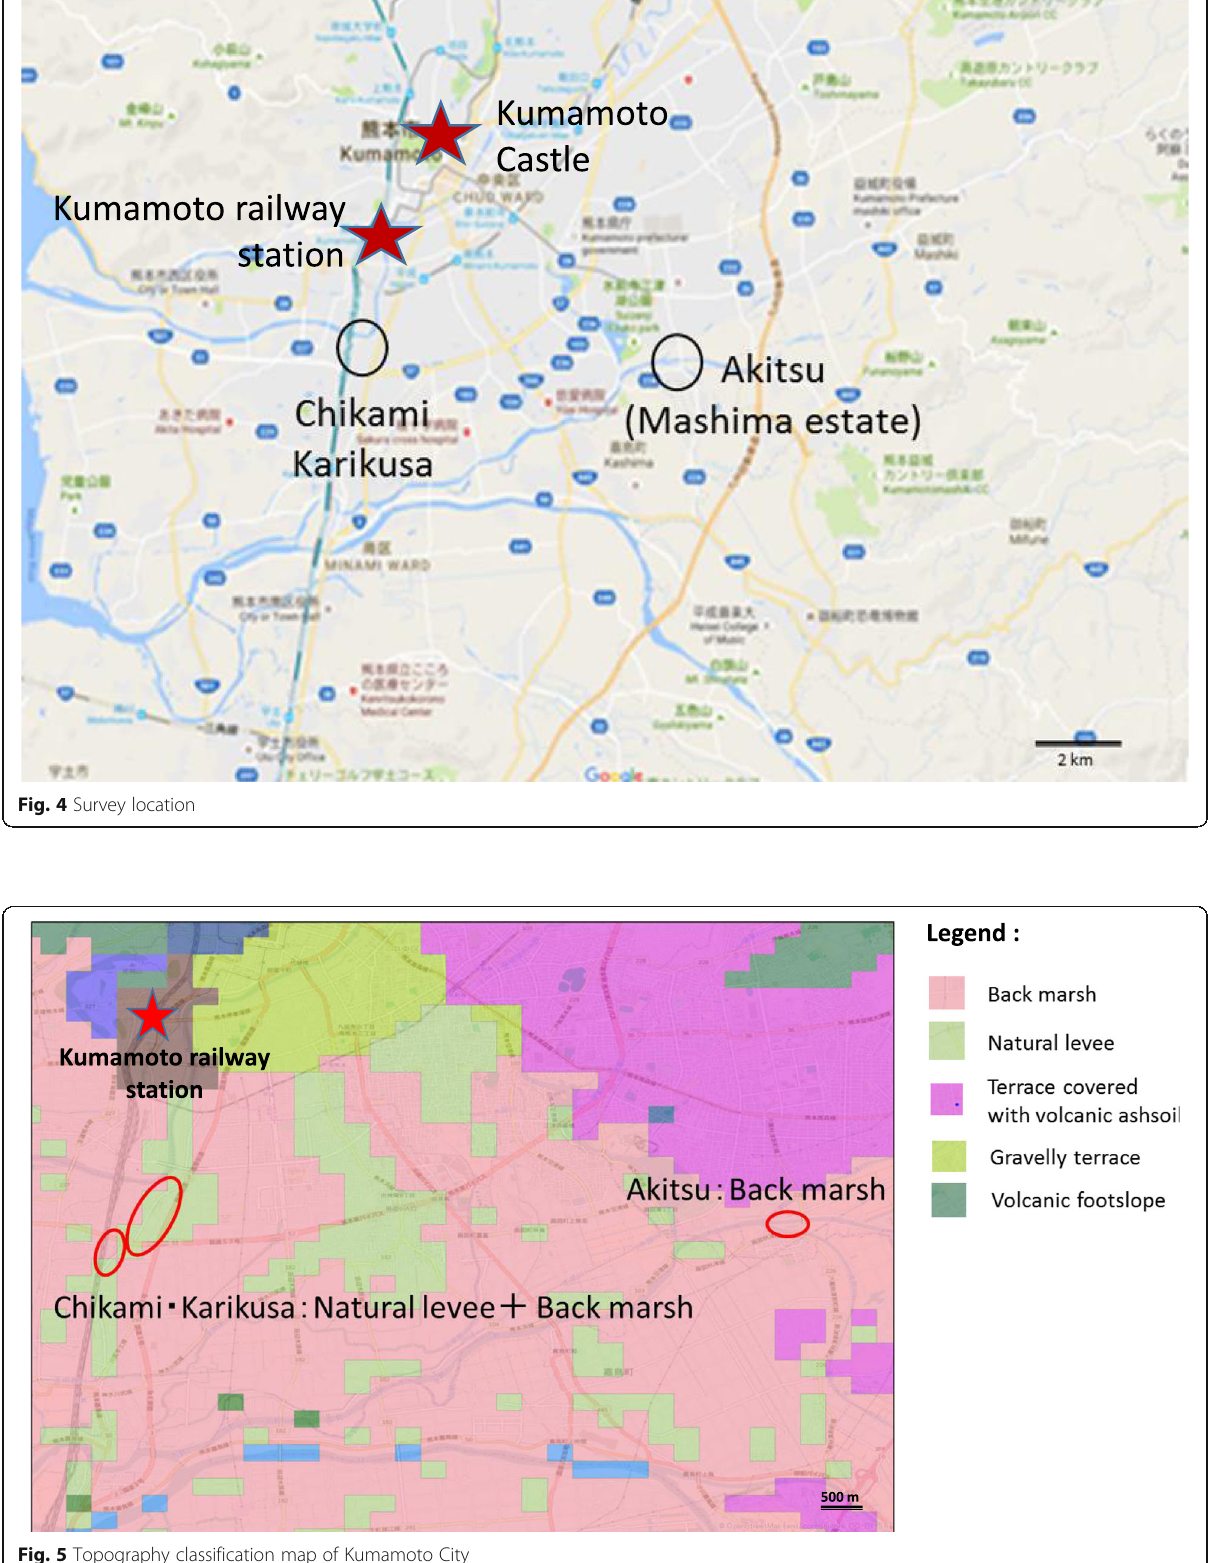
Fig. 5 Topography classification map of Kumamoto